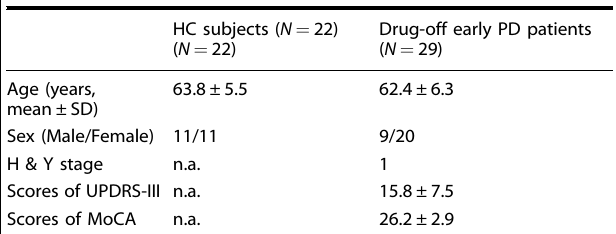
Table 4. Subject